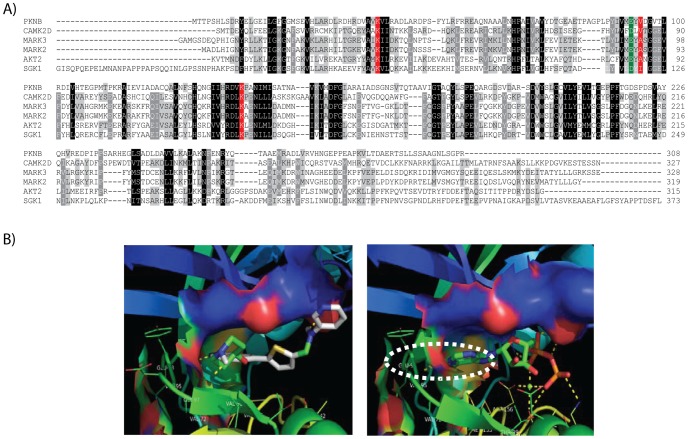
PknB kinase docking to GSK1598164A.
A) Multiple sequence alignment of Mycobacterium PknB kinase with selected human kinases. Human kinases were selected on the criteria of having available PDB structures and top Psi-BLAST scores to M. bovis transmembrane serine/threonine-protein kinase B (pknB). First sequence in the alignment (gene name; PDB identifier) is M. tuberculosis transmembrane serine/threonine-protein kinase B (PknB; 3F69), which is 99% identical to M. bovis PknB and was used in compound docking models. Other sequences are CAMK2D (2EWL), MARK3 (2QNJ), MARK2 (3IEC), AKT2 (1GZK) and SGK1 (2R5T). Residues known to interact with ADP in pknB are highlighted in red. The amino acids aligned with Glu93, which may be essential for the binding of the GSK1132084A, are highlighted in green. B) Binding models of the GSK1598164A and ADP within pknB binding site (left and right panels, respectively).